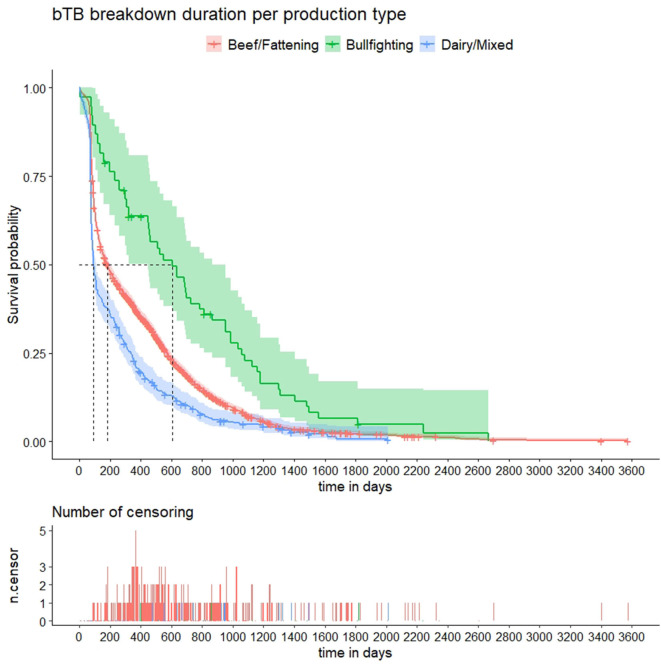
Kaplan–Meier survival estimates of bovine tuberculosis (bTB) breakdown duration by production type. Crosses indicate censored observations. Number of censoring table shows the number of herds that did not clear the infection during the study period or were depopulated during the study period at regular time intervals.